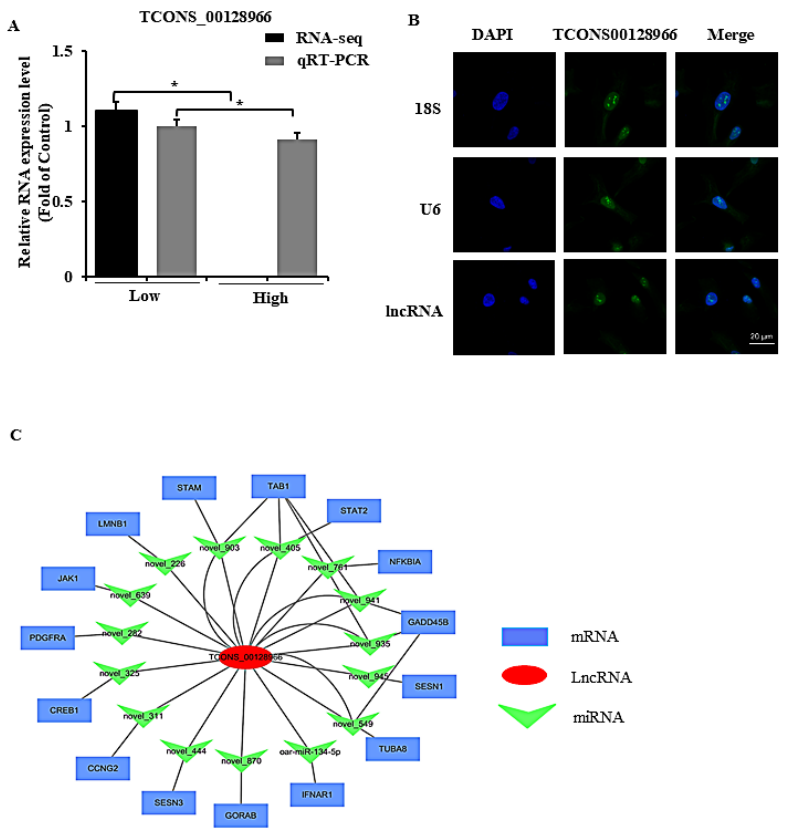
Figure 6. Downregulation of lnc GDAR in GCs is related to apoptosis. ( A ) The expression of lnc GDAR detected by qRT-PCR. ( B ) Expression location of lnc GDAR in GCs by fluorescence in situ hybridization (FISH), lnc GDAR was labeled with green fluorescence, and the nuclei were stained by DAPI (blue). Scale bar: 20 μm. ( C ) LncRNA-miRNA-mRNA interaction network consisting of 1 lncRNAs (red circles), 15 miRNAs (green arrows), and 15 mRNAs (green squares). lncRNA, long non-coding RNA; miRNA, microRNA; mRNA, messenger RNA. Values represent means ± SEM for three individuals. * p <